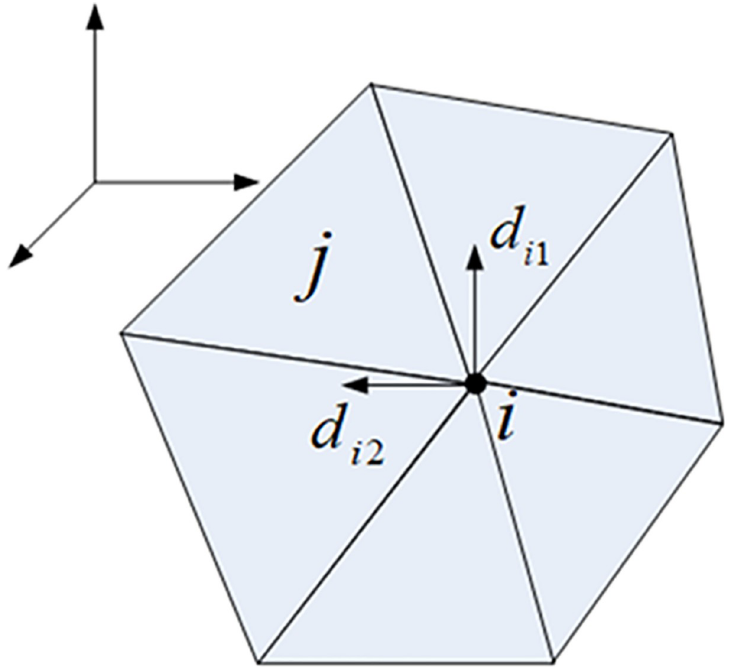
Fig 8. Illustration of parameters in termination criterion E v